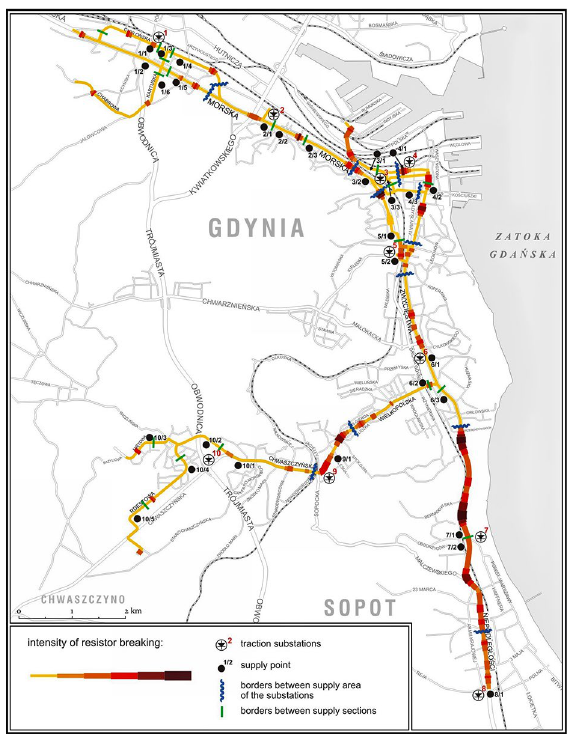
Fig. 17. Resistor braking intensity map –